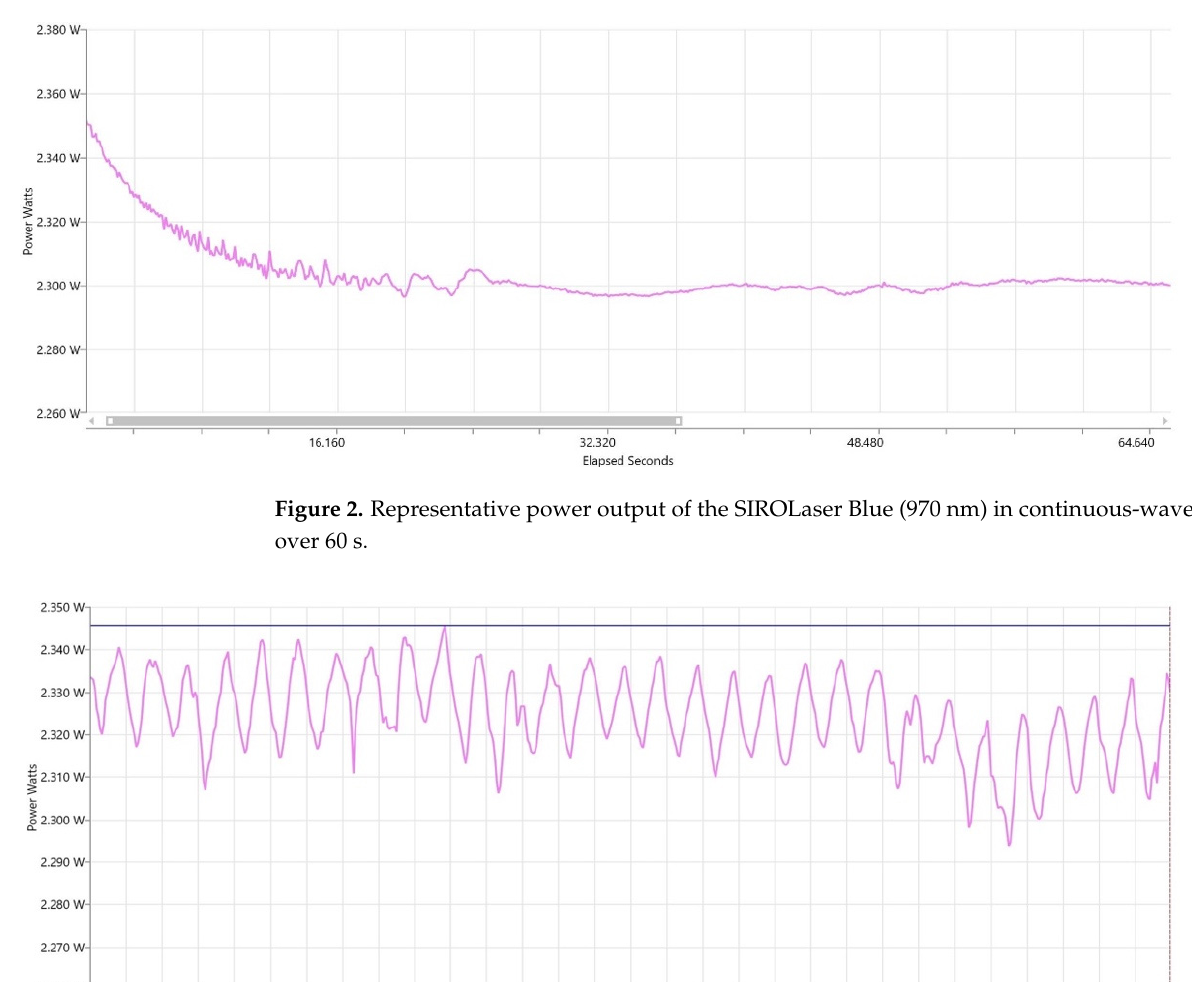
Figure 3. Representative power output of the Picasso (810 nm) in continuous-wave mode over 60 s.